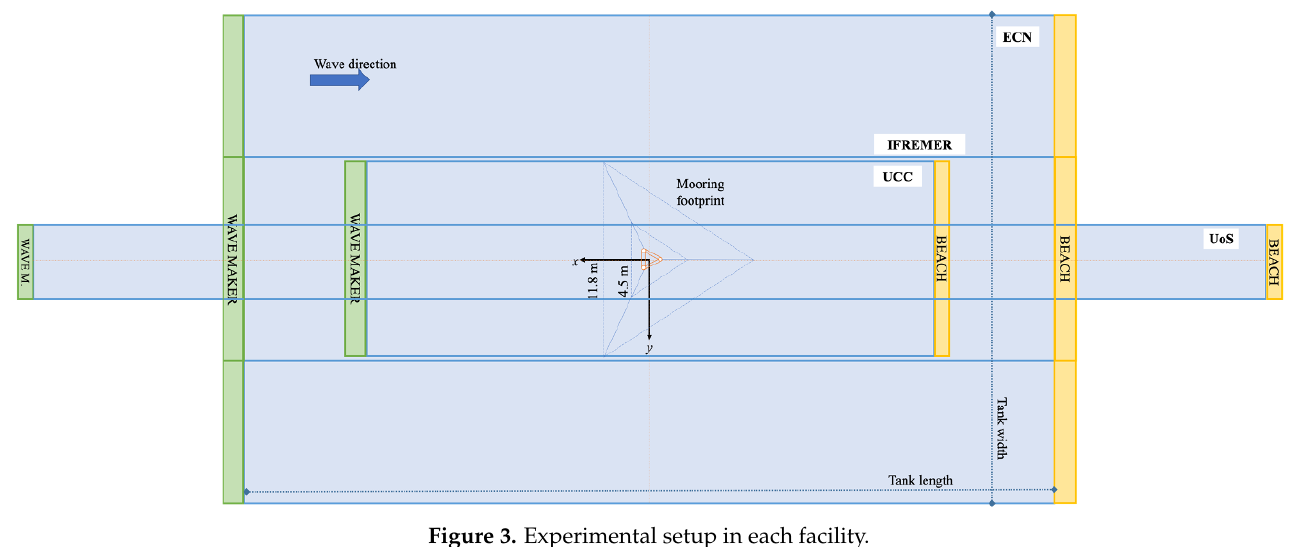
Figure 3. Experimental setup in each